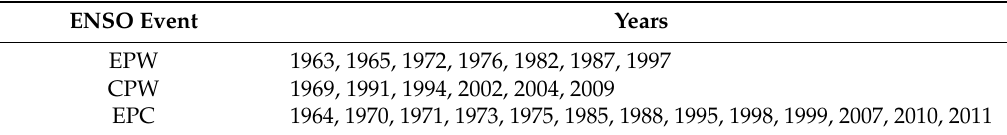
Table 2. Years of EPW, CPW and EPC.